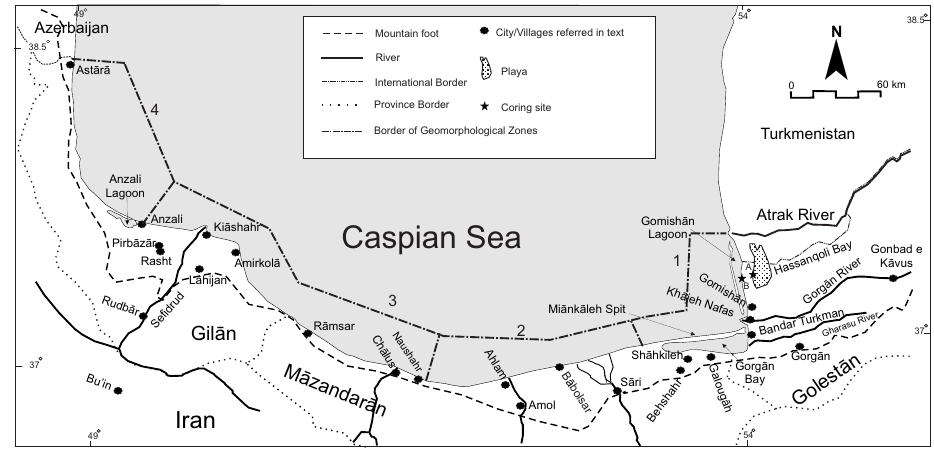
Fig. 3. The Caspian coast of Iran, with its prominent coastal landforms and major rivers. The cities mentioned in this paper are marked on the map. The morphological zones of the south Caspian coast (Voropaev et al., 1998) are highlighted. 1: Coasts with gentle slopes on the beach and in the nearshore zone. 2: Coasts with gentle slopes on the beach and steep slopes in the nearshore zone. 3: Coasts with steep slopes on the beach and nearshore zone. 4: Coasts with steep slopes on the beach and gentle slopes in the nearshore zone. Core locations are indicated by the star